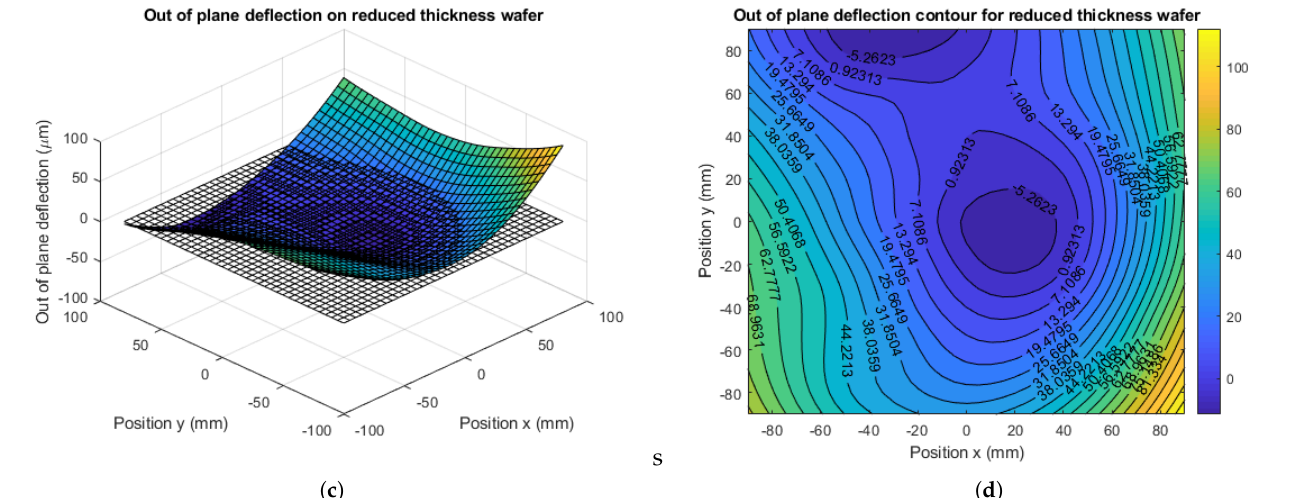
Figure 11. Out-of-plane experimental measurements. ( a ) Wafer surface for the reference specimen; ( b ) Isoline contour of out-of-plane deflection for the reference specimen; ( c ) Wafer surface for the reduced specimen; ( d ) Isoline contour of out-of-plane deflection for the reduced specimen.